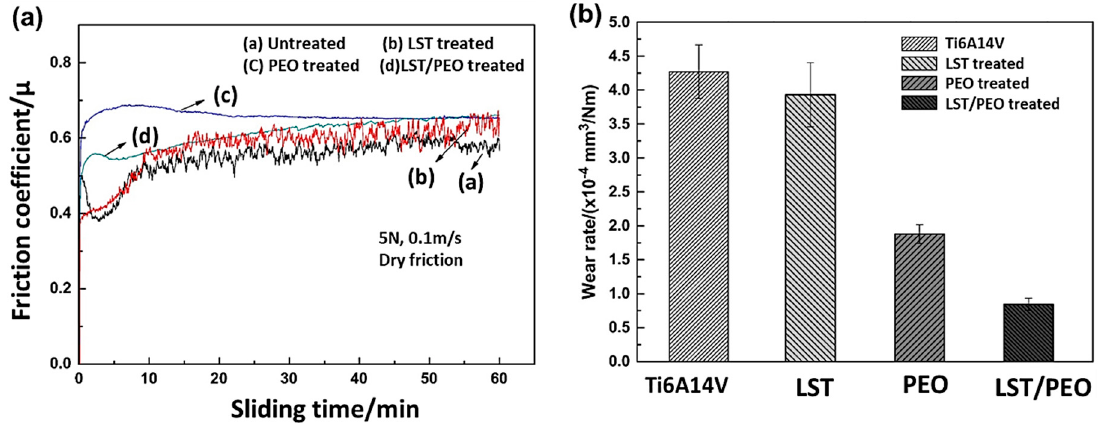
Figure 21. Variation of ( a ) friction coefficient and ( b ) wear rate. Reproduced with permission from [174]. Copyright Elsevier, 2015. The addition of MoS 2 solid lubricant on the samples resulted in a considerable reduc- tion in the COF at the end states of the LST, PEO treated sample compared to other samples as shown in Figure 22.